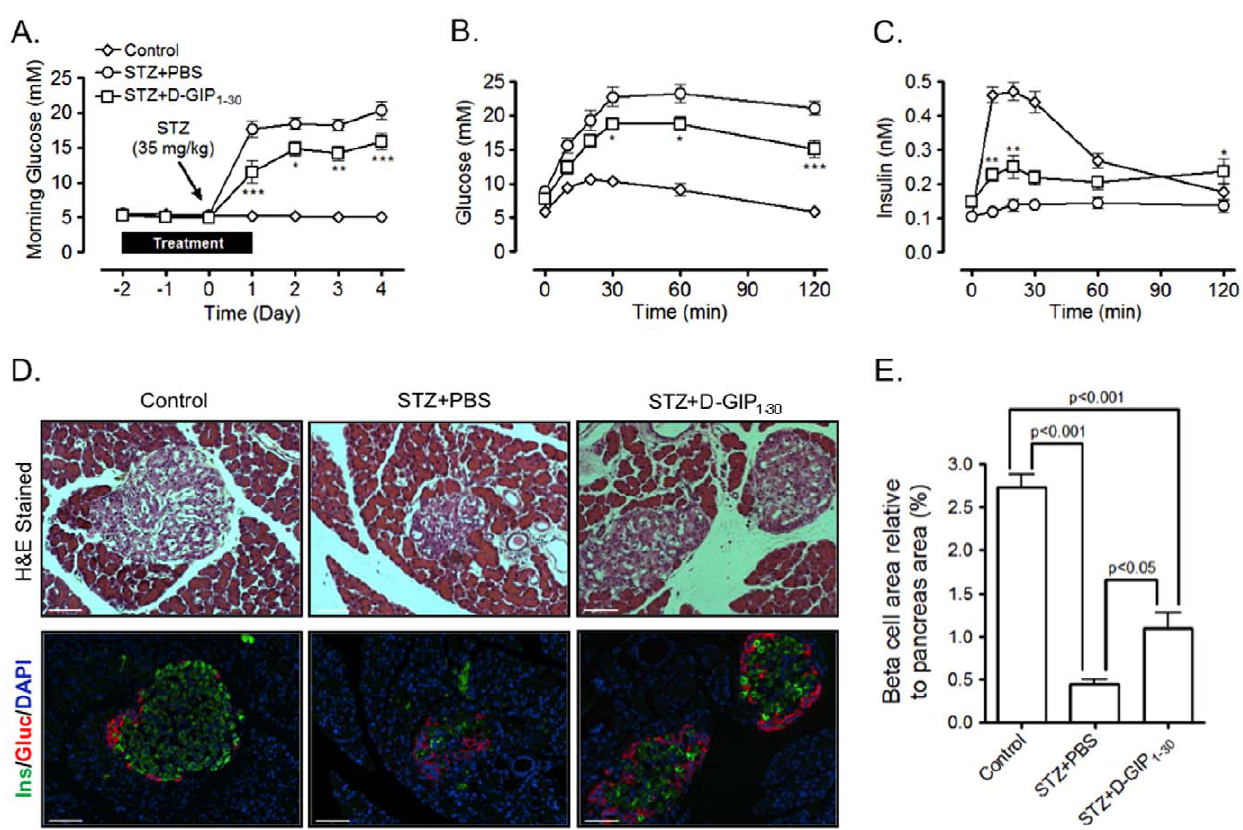
Figure 2. D-GIP 1–30 partially protects b -cells in streptozotocin (STZ) treated rats. A , Glucose levels were monitored 2 days prior to (day 2 2) and 4 days (day 4) following an i.p. injection of STZ (35 mg/kg BW; on day 0) to Lean rats treated twice daily with PBS or D-GIP 1–30 (8 nmol/kg BW) from day 2 2 to day 1 as well as in untreated Lean rats. B , On day 5, OGTTs were performed on rats described in A and blood glucose levels measured. C , Insulin levels were determined from blood samples collected in B . For A–C , Mean 6 SEM (n=4); *, p , 0.05, **, p , 0.01, ***, p , 0.001 vs rats treated with STZ and PBS. D , Representative images of pancreases collected on day 6 stained with hematoxylin & eosin or with insulin (green), glucagon (red) and DAPI (blue); scale bar=100 m m. E , Mean 6 SEM of -cell (insulin positive) area relative to pancreas area (n=4; 4 sections per animal); significance as